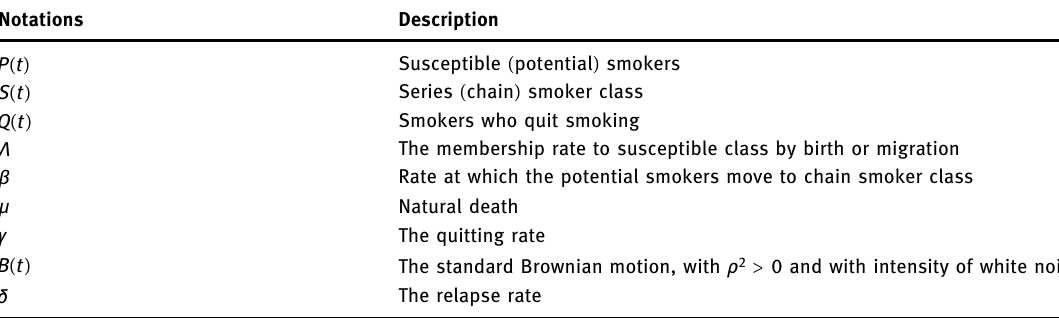
Table 1: Parameters and description